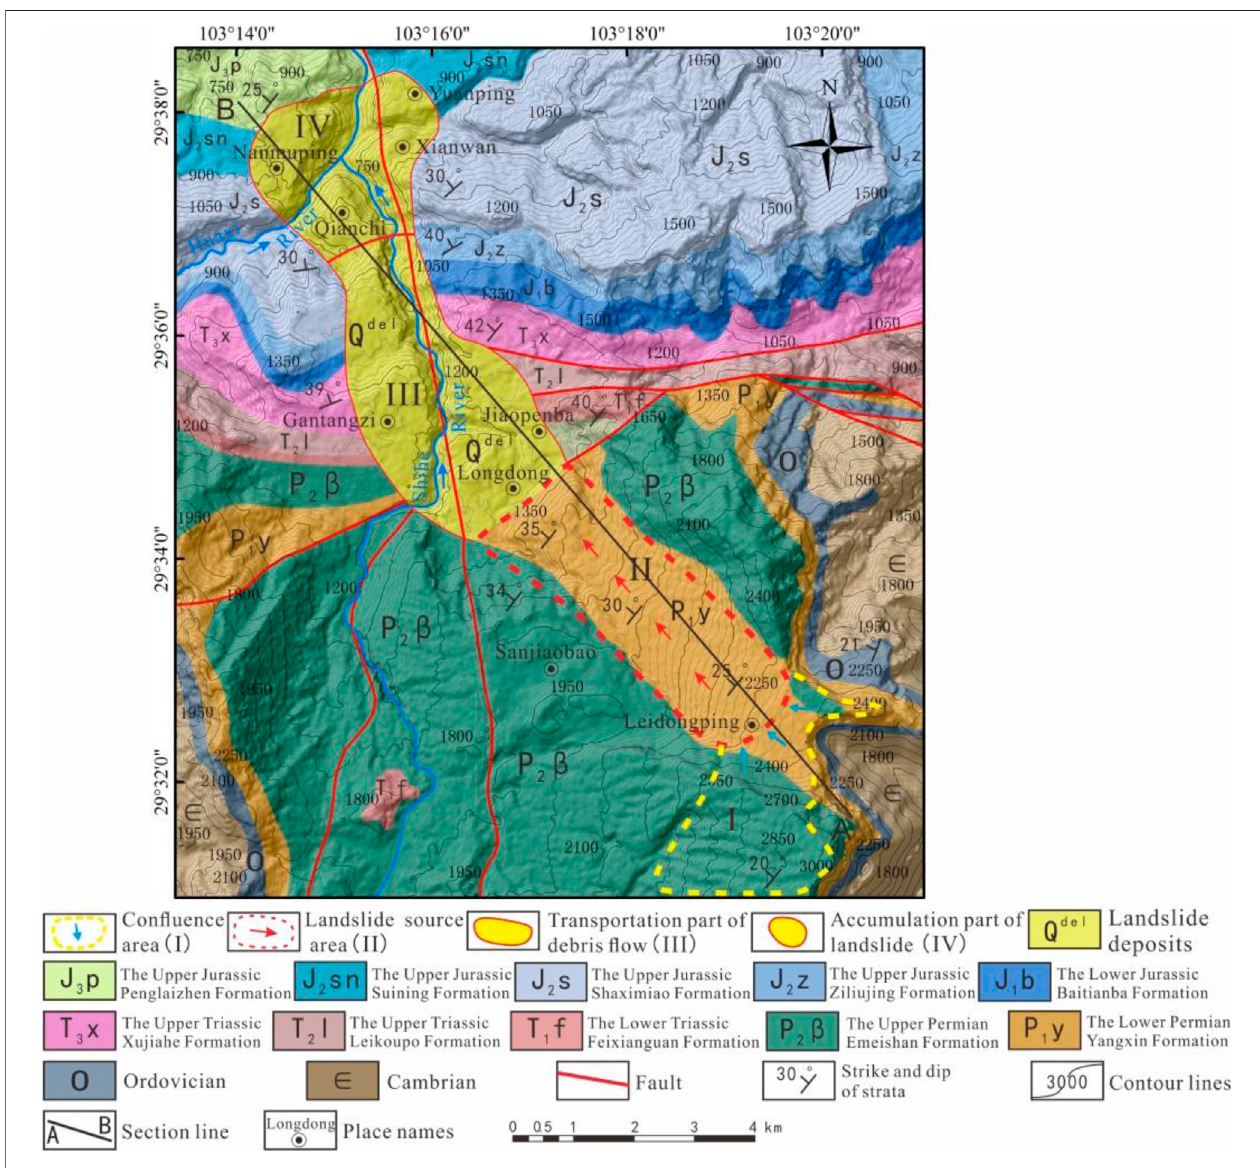
FIGURE 3 | Geomorphological sketch map of the Jiaopenba paleolandslide area.